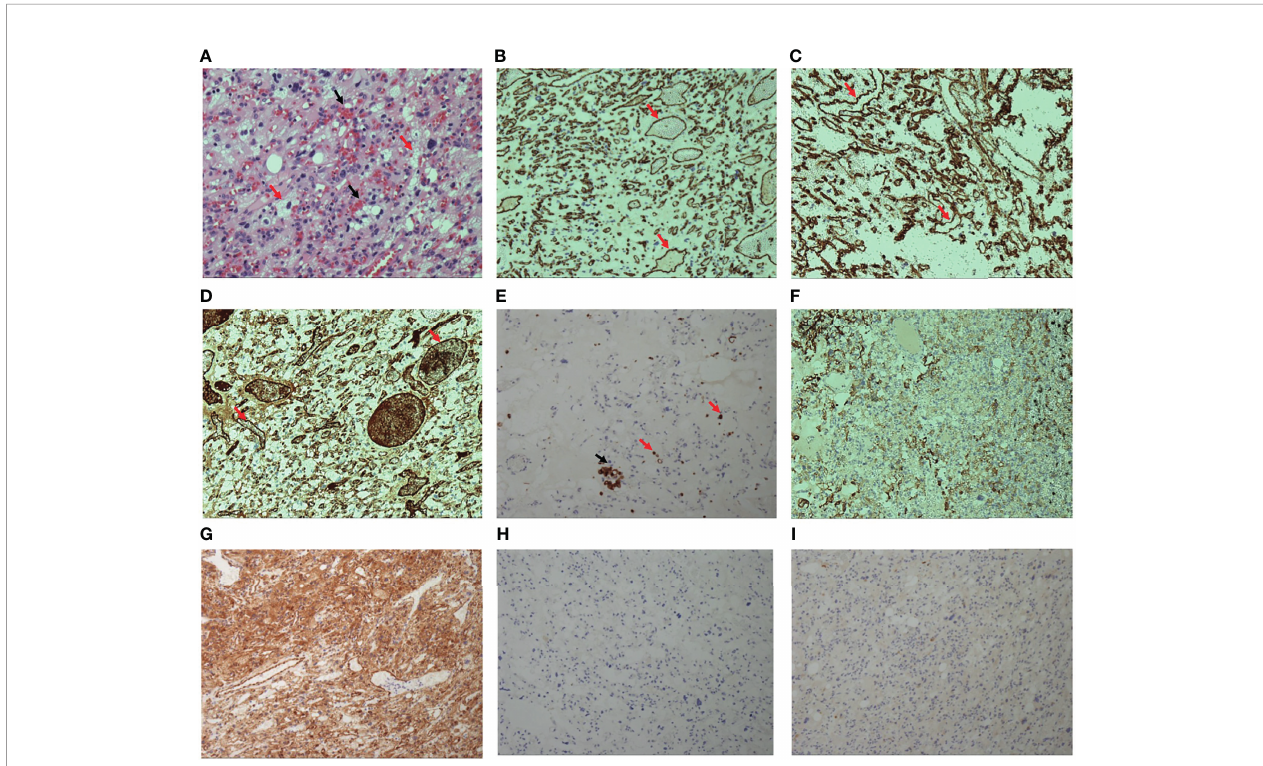
FIGURE 2 | Hematoxylin-eosin staining of the excised mass (×20) (A) shows numerous capillary vessels containing red blood cells (black arrows) distributed in the vacuolated stromal cells (red arrows). Immunohistochemistry staining of the mass shows that the endothelial cells of capillary vessels (red arrows) were positive (brown=positive) for CD31 (B) , CD34 (C) , and F8-R (D) . Some interspersed monocytes (red arrows) and macrophages (black arrow) were positive for CD68 (E) . Vacuolated stromal cells are positive for GFAP (F) and NSE (G) . CgA (H) and Syn (I) is negative among the whole sample